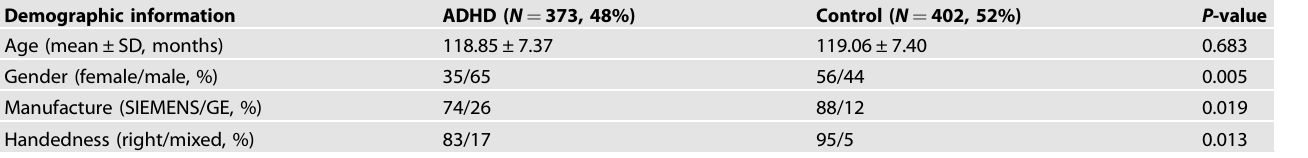
Table 2. Demographic information of the dataset used in this study. Demographic